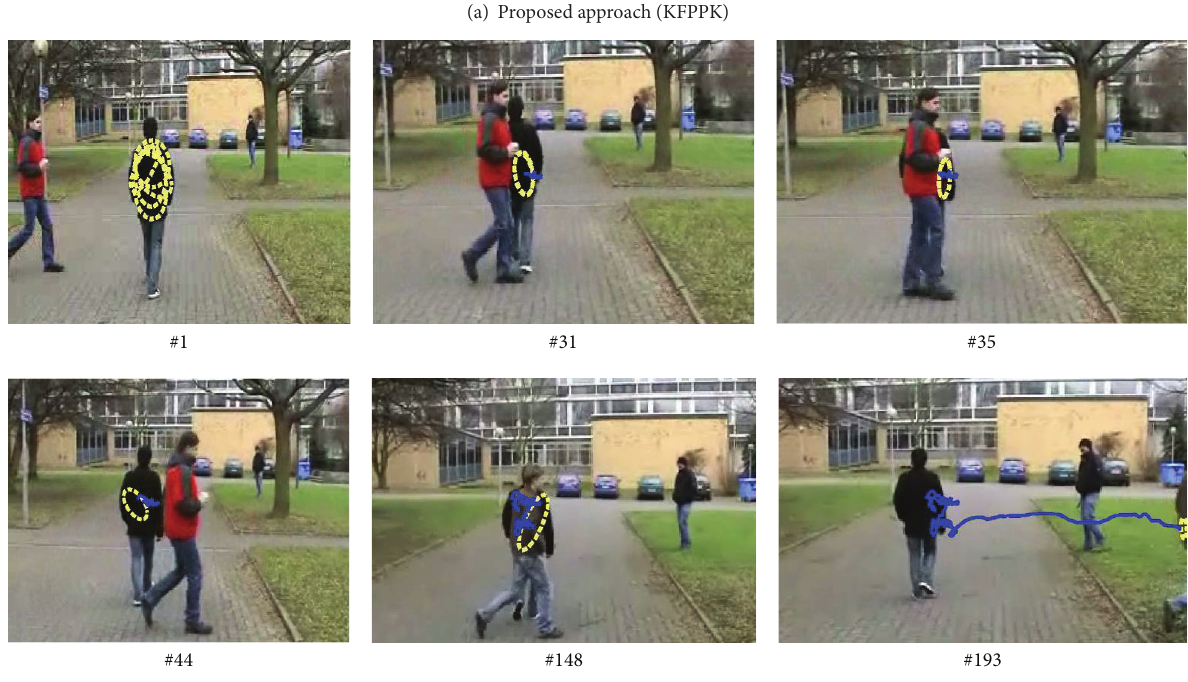
situations (scale variation, pose, rotation, and